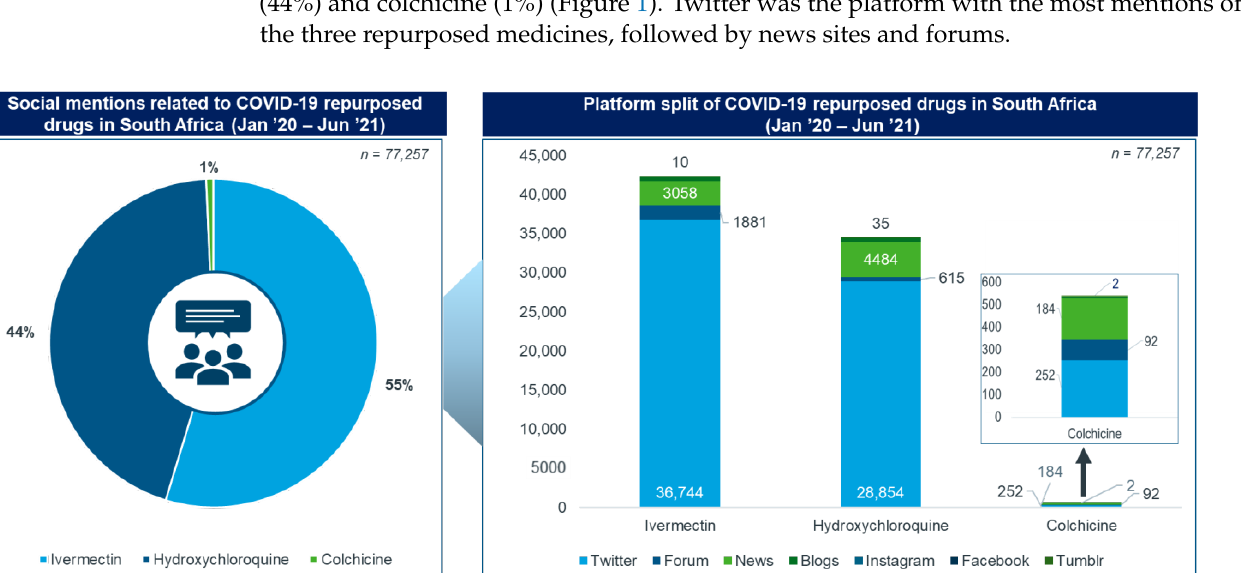
Table 1. Summary of posts